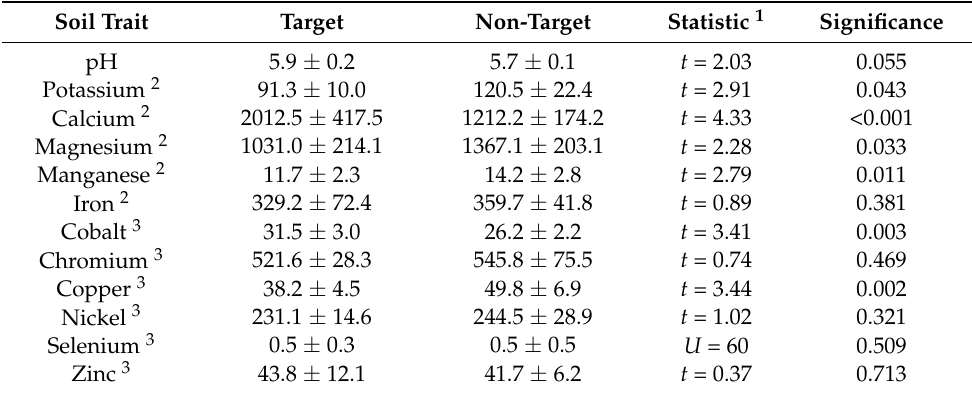
Table 5. The influence of proximity to Cycas micronesica trees on soil chemical traits in schist soils on Yap. Target soils were collected underneath cycad trees. Non-target soils were collected 5-m from focal cycad trees. Means ± SE, n =